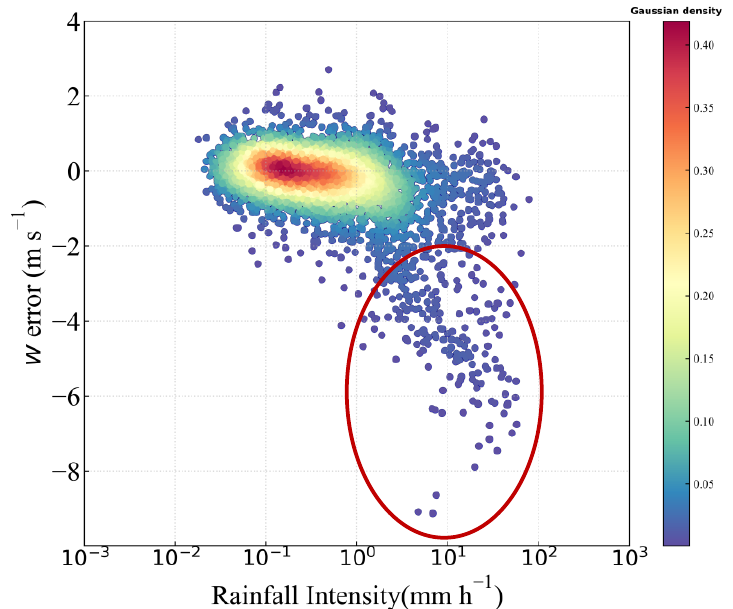
Figure 11. Variation of w error with precipitation intensity.